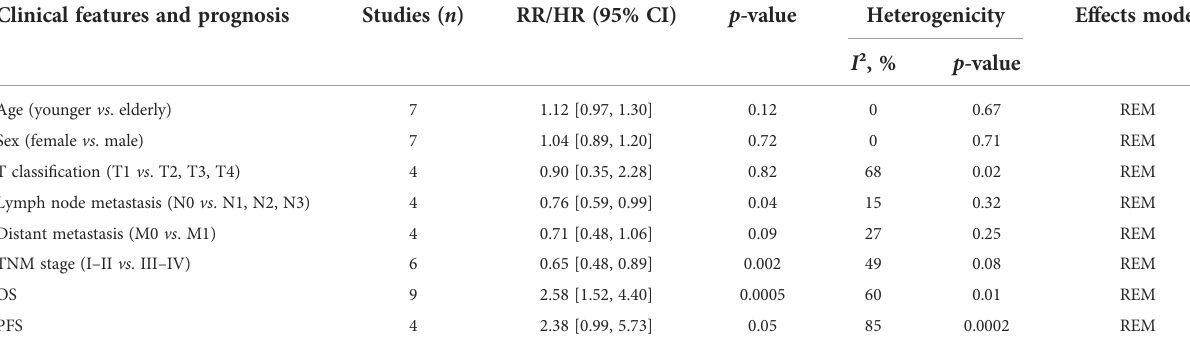
TABLE 4 Meta-analysis results of the associations of increased TDO2 expression with clinicopathological parameters. Clinical features and prognosis